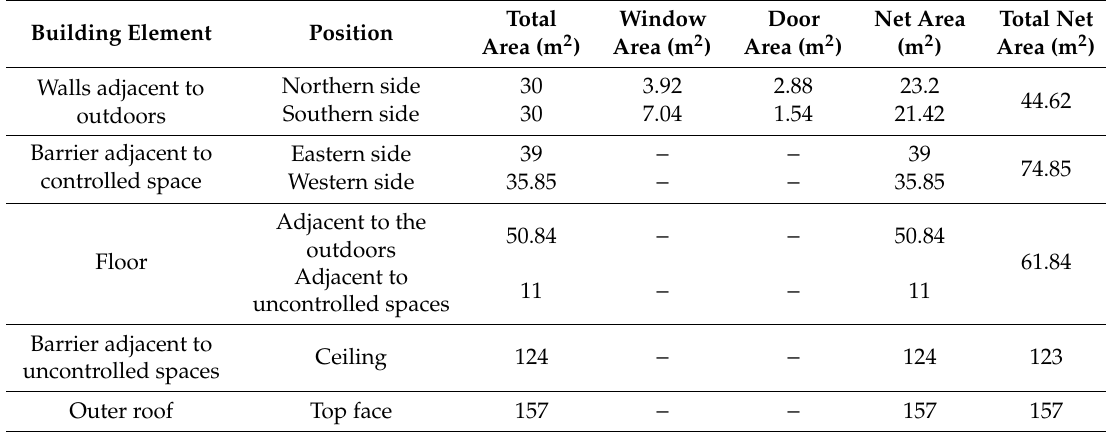
Table 2. Dimensional specifications of the building envelope.